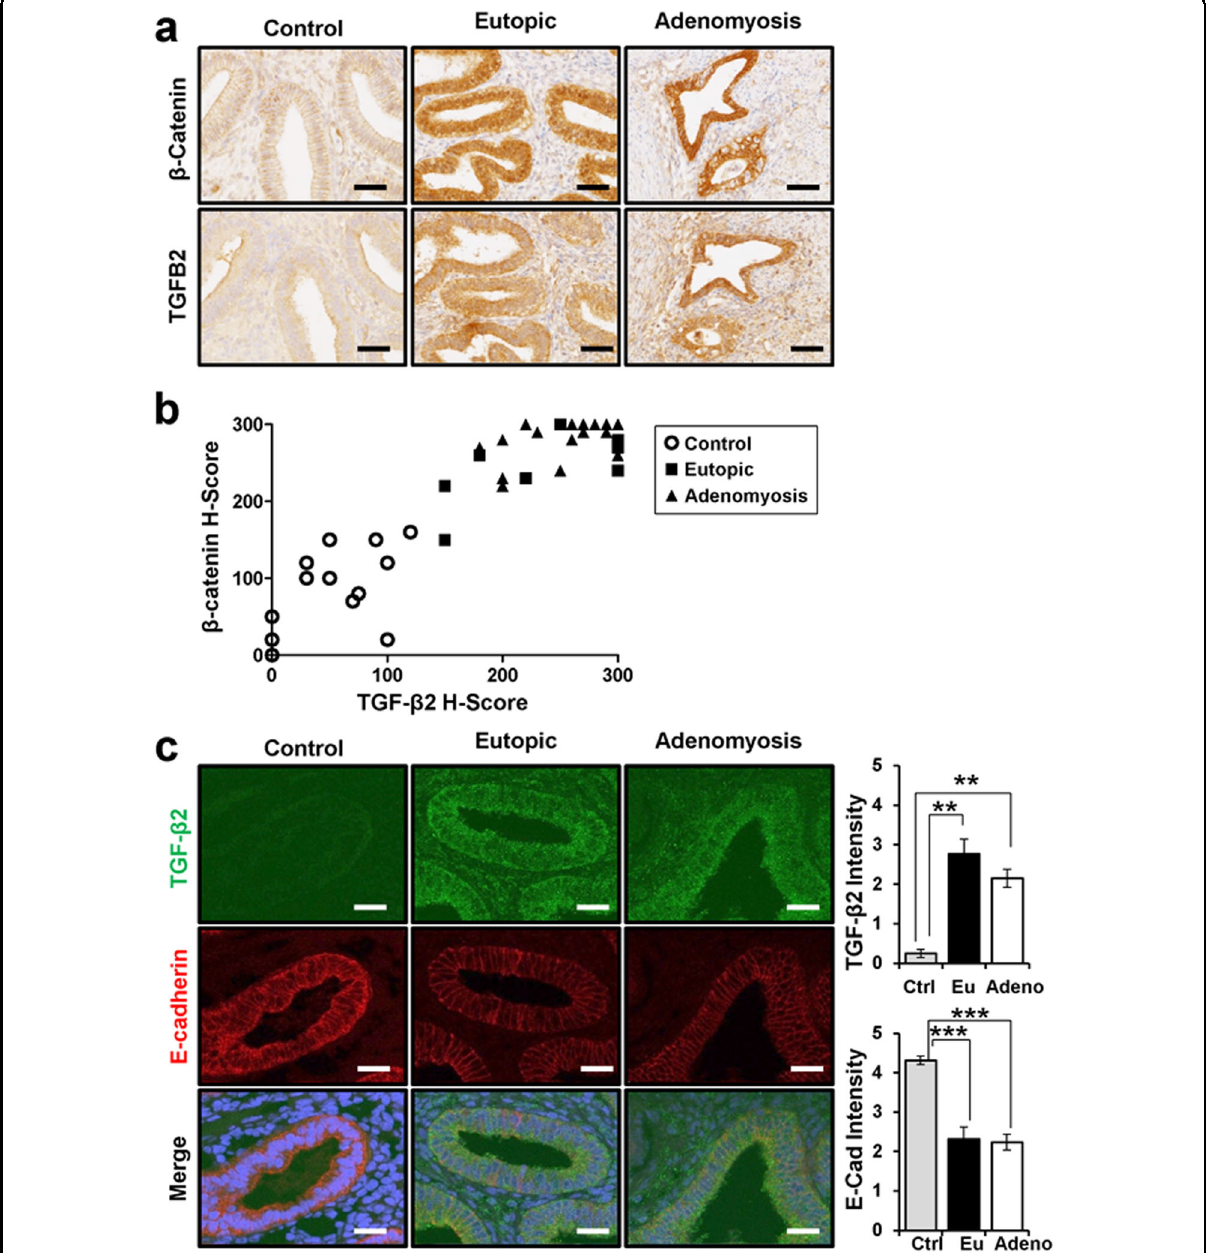
Fig. 4 Positive correlation between TGF- β 2 and β -catenin in the human endometrium with and without adenomyosis. a Representative photomicrographs of immunohistochemical staining of TGF- β 2 and β -catenin in the endometrium of women with and without adenomyosis. b Correlation analysis of TGF- β 2 and β -catenin in control ( n = 14) and endometrial ( n = 8) and adenomyotic lesions ( n = 30) of adenomyosis based on immunohistochemistry results (correlation coef fi cient = 0.9136, p < 0.0001). c Immuno fl uorescence analysis and intensity quanti fi cation of TGF- β 2 and E-cadherin in women endometrium without adenomyosis ( n = 14) and endometrium ( n = 13) and adenomyotic lesions ( n = 29) of adenomyosis. Nuclei were counterstained with DAPI. Scale bars represent 50 μ m. The results represent the mean ± SEM. ** p < 0.01 and *** p <